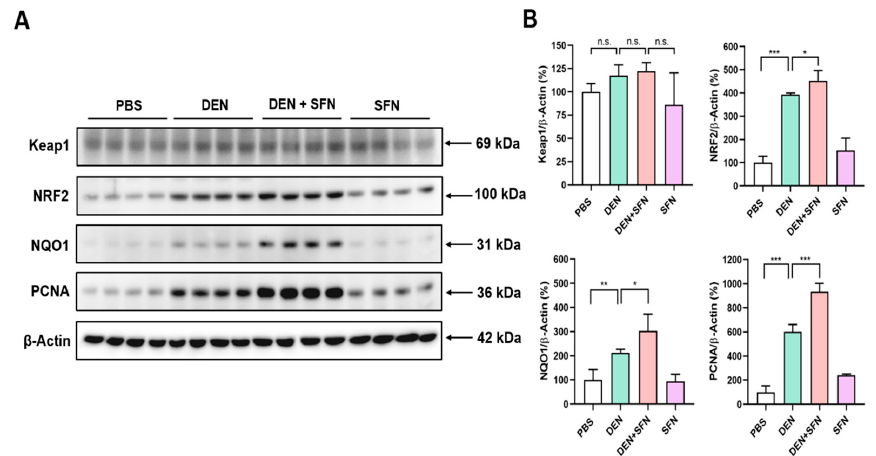
Figure 3. The effect of SFN on expression of NRF2, NQO1, and PCNA in the livers of DEN-treated mice. ( A ) Total protein lysates were prepared from livers of 9-month-old mice treated with vehicle (PBS), DEN, DEN plus SFN, or SFN alone ( n = 4 for each group), and subjected to Western blotting with antibodies against Keap1, NRF2, NQO1, and PCNA. β -Actin served as an internal control. ( B ) The quantification of protein levels was conducted by using Image J software, and statistical significance was determined by the two-tailed unpaired Student’s t test. Data are shown as the mean ± SD. * p < 0.05; ** p < 0.01; *** p < 0.001; n.s.: non-significant.